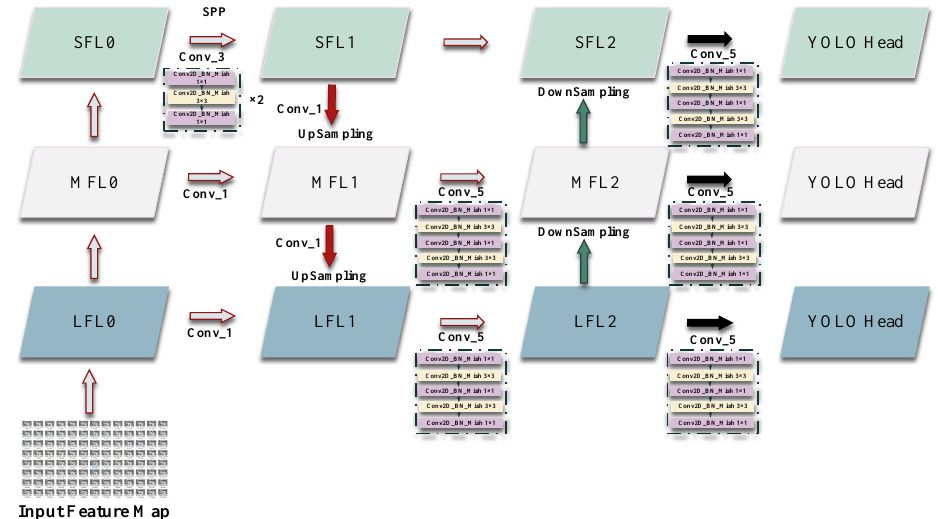
Figure 4. Improved multi-scale prediction